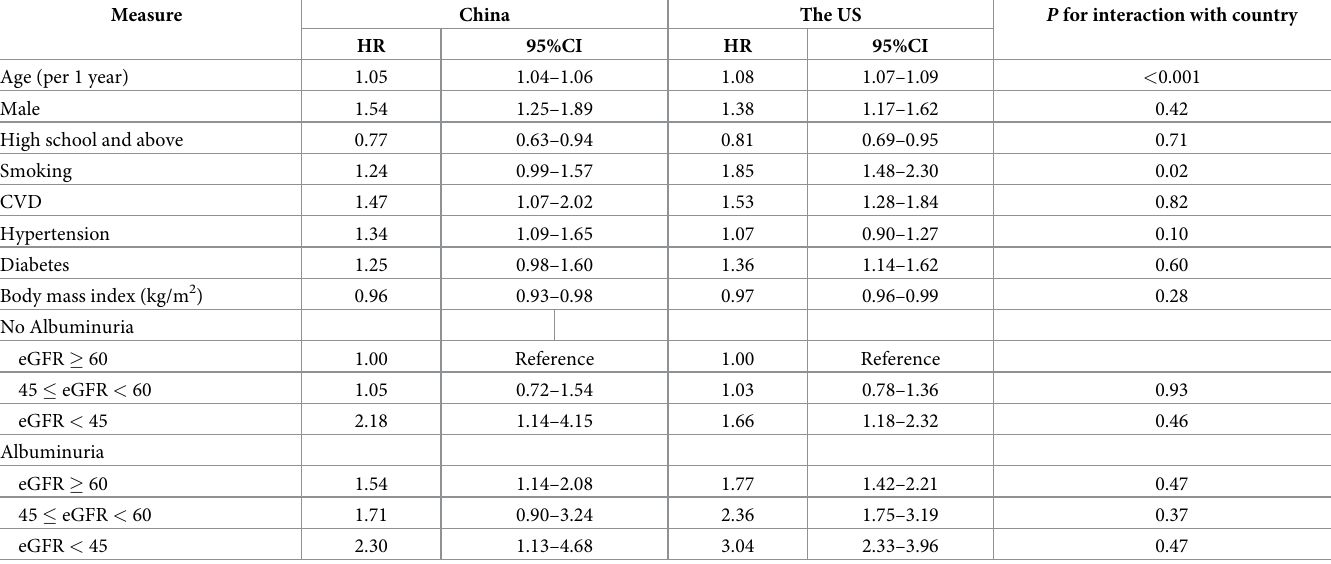
Table 4. Hazard ratios for all-cause mortality with interactions by risk factors in the combined